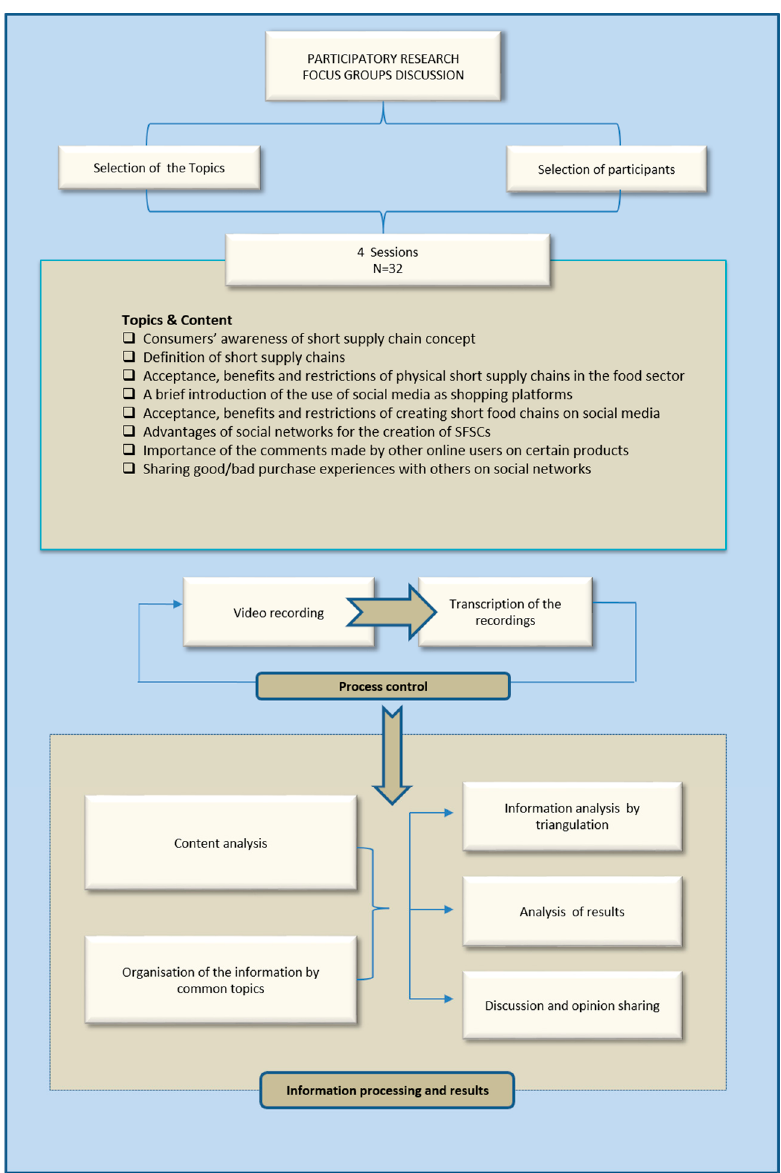
Figure 1. Structure of the focus group and the methodological approach .